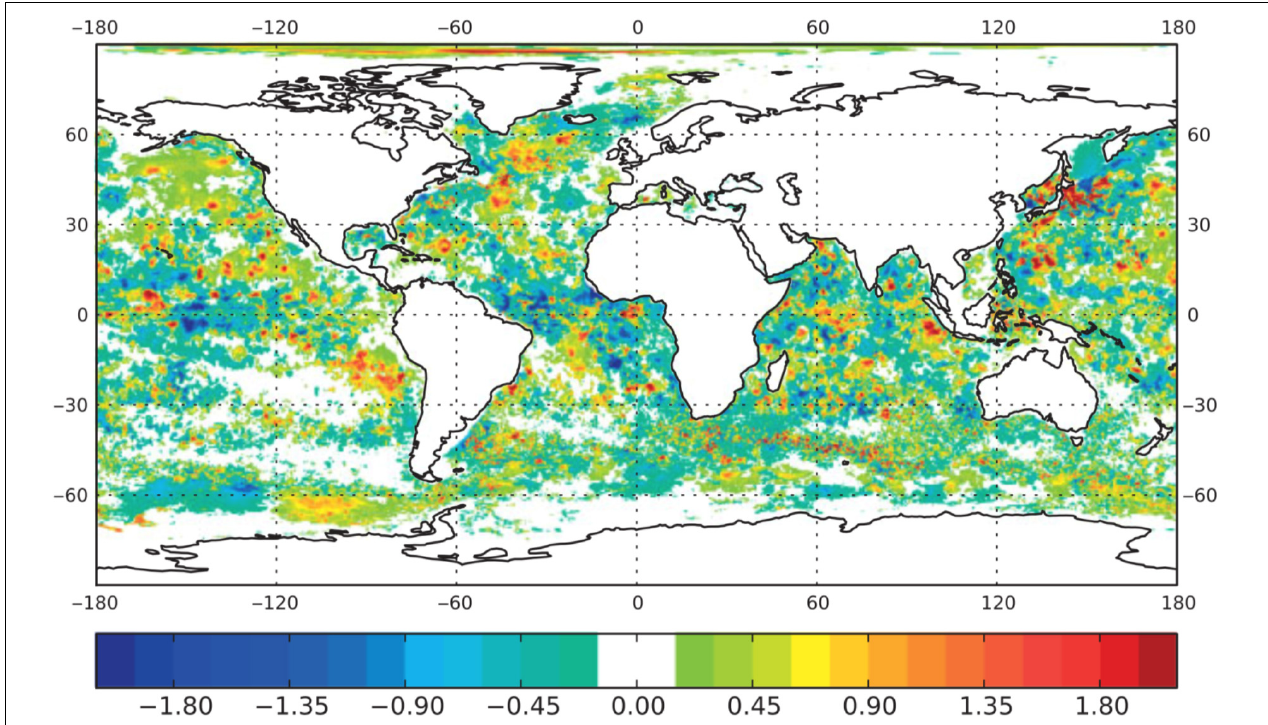
FIGURE 11 | Map of the temperature difference (operational minus ‘no Argo’; ◦ C) at 110 m depth, calculated from daily average fields from the last day of an Argo Observing System Experiment (31 July, 2011) [Source: adapted from Lea et al. (2014), Copyright Royal Meteorological Society, printed with